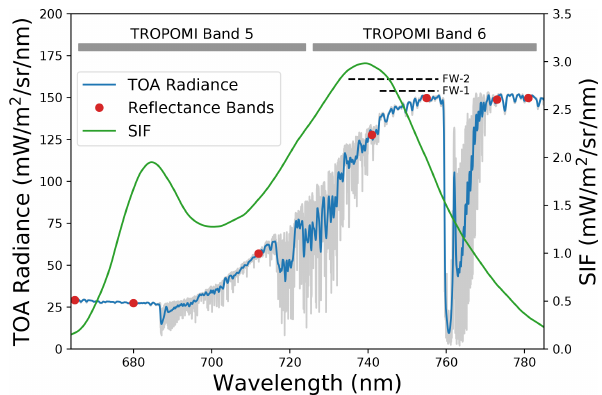
Figure 1. Top-of-atmosphere (TOA) radiance spectrum and top-of- canopy SIF spectrum from a green vegetation surface in the 665– 785nm spectral range covered by TROPOMI’s bands 5 and 6. The TOA radiance spectrum at high spectral resolution is plotted in gray, and the result of the convolution with TROPOMI’s spectral resolu- tion is shown in blue. The horizontal dashed lines show the span of the baseline SIF retrieval fitting window (FW-1, 743–758nm) and the secondary fitting window (FW-2, 735–758nm). The spectral lo- cations of the 3nm macro-channels at which spectral reflectance data are provided in the TROPOSIF product are marked in red. A typical SIF spectrum is depicted in